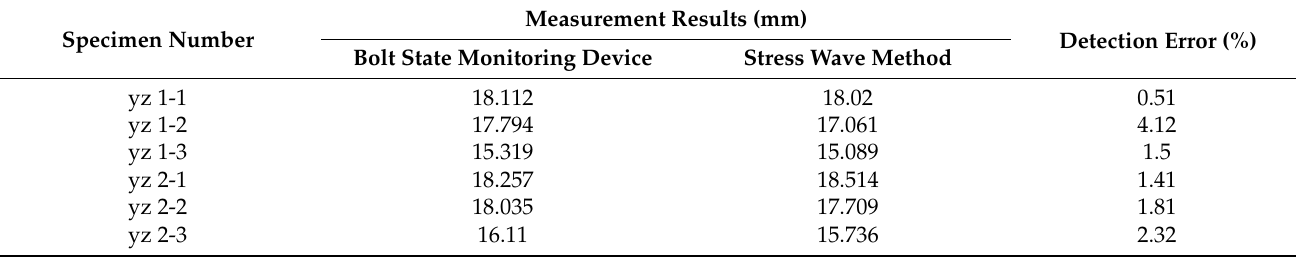
Table 3. Validation of experimental test results and